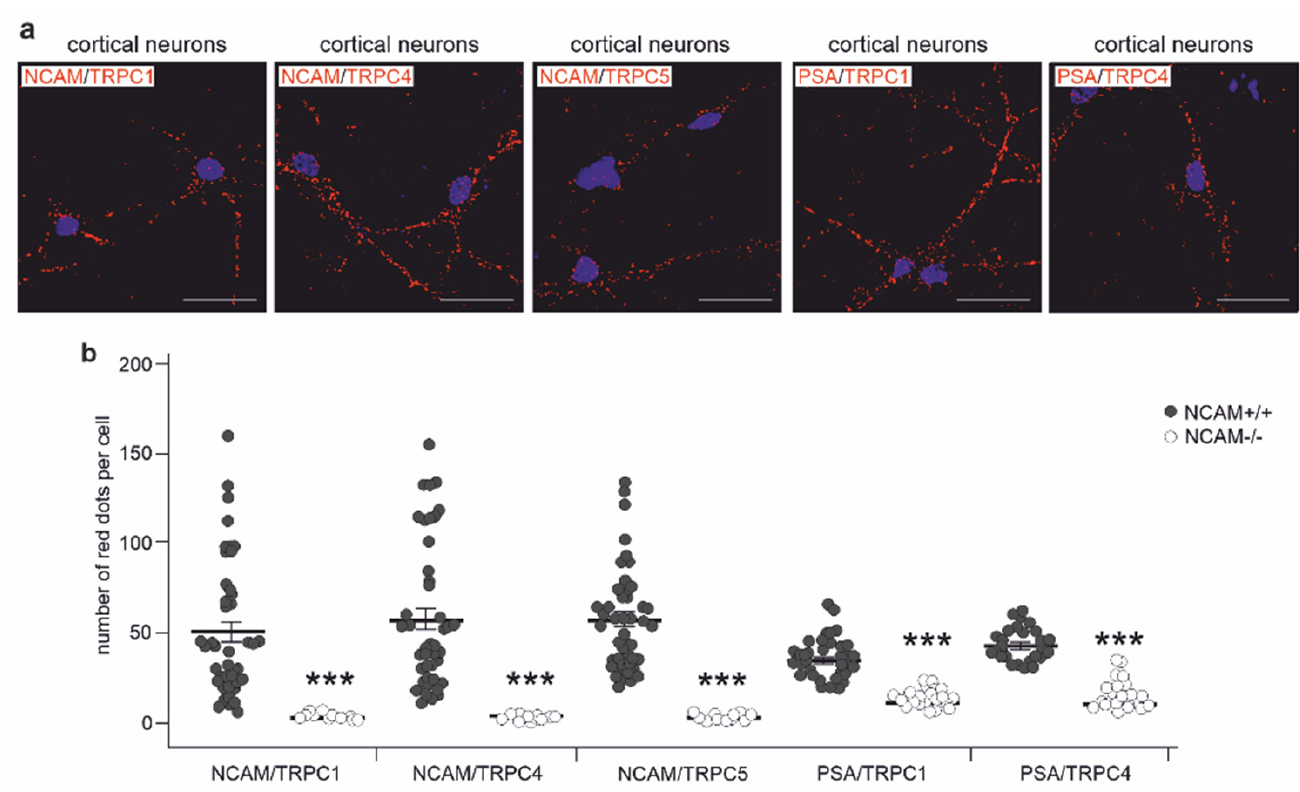
Figure 6. NCAM localizes in close proximity to TRPC1, − 4, and − 5 in cortical neurons. ( a , b ) Cultured cortical neurons from wild-type (NCAM+/+) and NCAM-deficient (NCAM − / − ) mice were sub- jected to proximity ligation assay with rabbit NCAM antibody GTX133217 and mouse TRPC1 antibody E-6, TRPC4 antibody N77/15, or TRPC5 antibody N67/15, as well as with mouse PSA antibody 735 and rabbit TRPC1 antibody GTX54876 or TRPC4 antibody ACC-119. Nuclei were stained with DAPI (blue). ( a ) Representative images are shown for proximity ligation of TRPCs and NCAM or PSA in wild-type neurons (scale bar: 20 µ m). Red dots indicate close proximity of NCAM or PSA with TRPCs in wild-type, but not NCAM-deficient neurons. Numbers of red dots from 3 independent experiments analyzing 10 neurons per group and experiment were determined. ( b ) Scatter plots show mean values ± SEM and single values for numbers of red dots per cell (*** p < 0.001 relative to wild-type neurons; Mann–Whitney test).